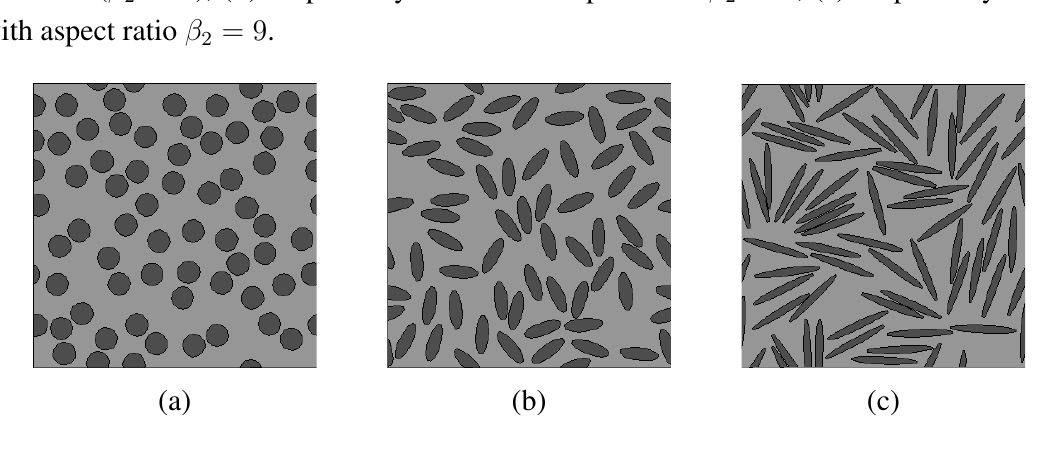
Figure 7. Variation of the normalized effective conductivity χ H /χ m for three microstructures in Figure 6 with perfect interfaces, determined by periodic FEM homogenization for phase contrast ( a ) α = 3 , ( b ) α = 10 and ( c ) α = 20 ; β denotes the inclusion aspect ratio and c (1) 2 the inclusion volume